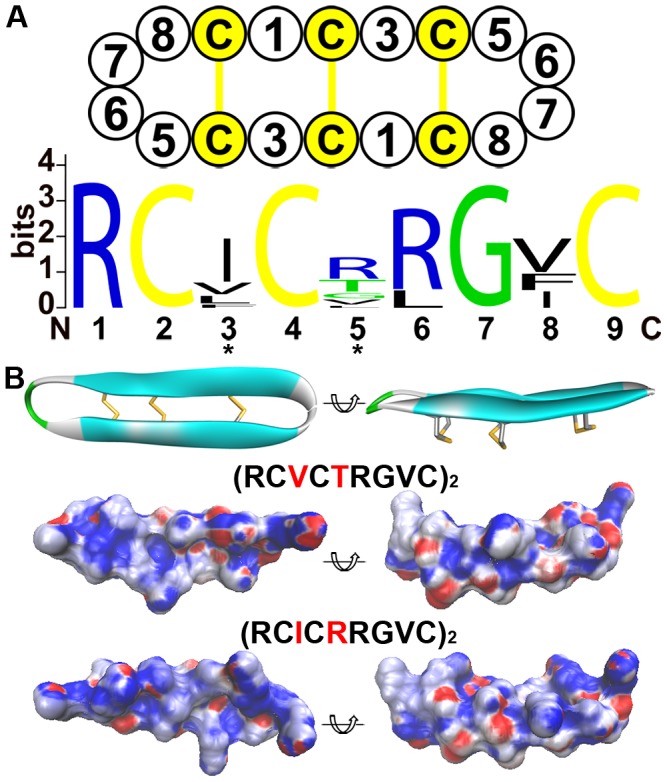
Sequence motifs and electrostatic features of primate cyclic θ-defensins.A: The θ-defensin octadecapeptide is formed by the head-to-tail ligation of two nonapeptides. The sequence logo for the nonapeptide is generated using all the primate θ-defensins. Sites 3I and 5R are under positive selection and are marked with asterisks. B: Surface electrostatic potential of the θ-defensins without or with the positively selected sites (3I and 5R).